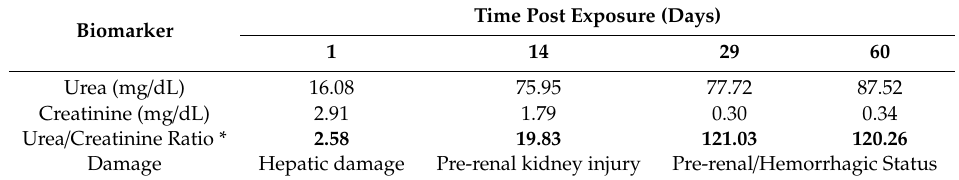
Table 2. Urea / creatinine ratio in the serum of the mice exposed to UP-CNTs at di ff erent exposure times.